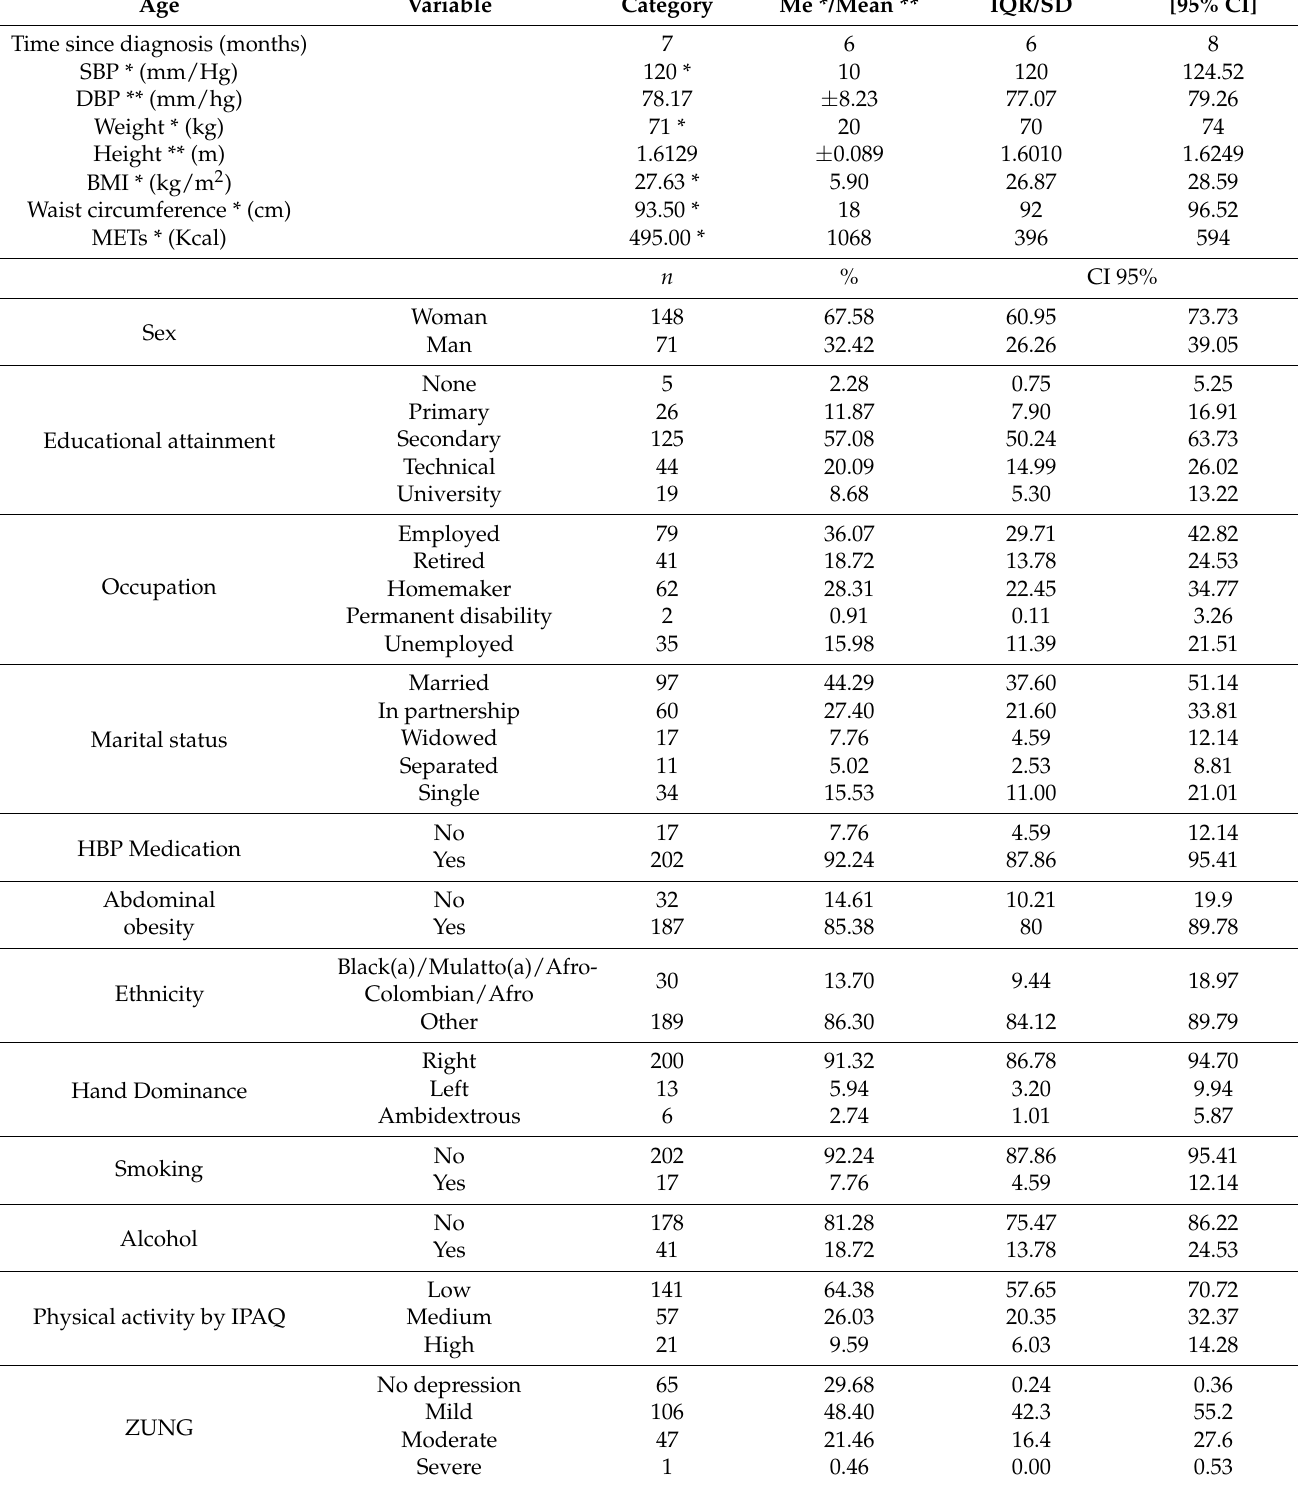
Table 1. Clinical and sociodemographic characteristics of